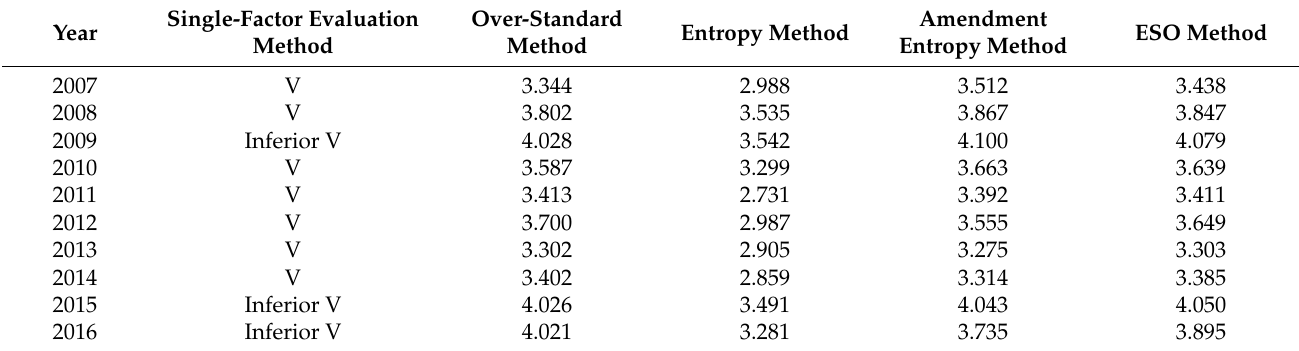
Table 6. Water quality indicator and grade of each